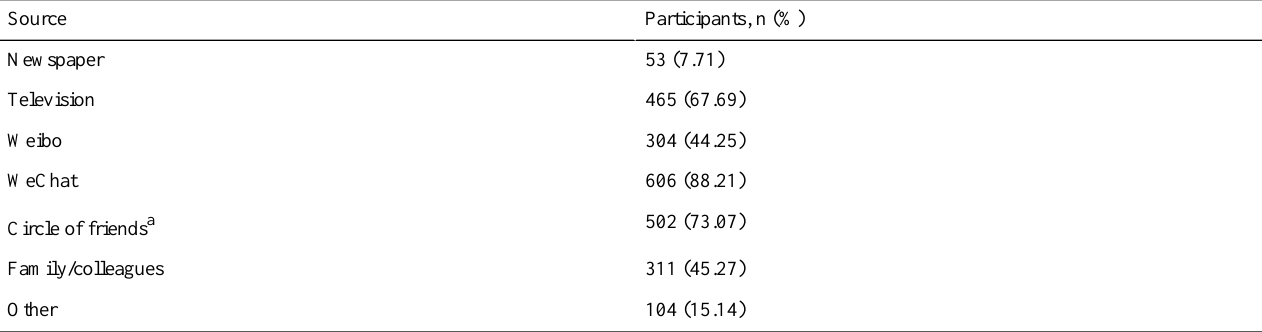
Table 3. Participants’answers to the multiple-choice question: what was your main way of obtaining information during the last month?